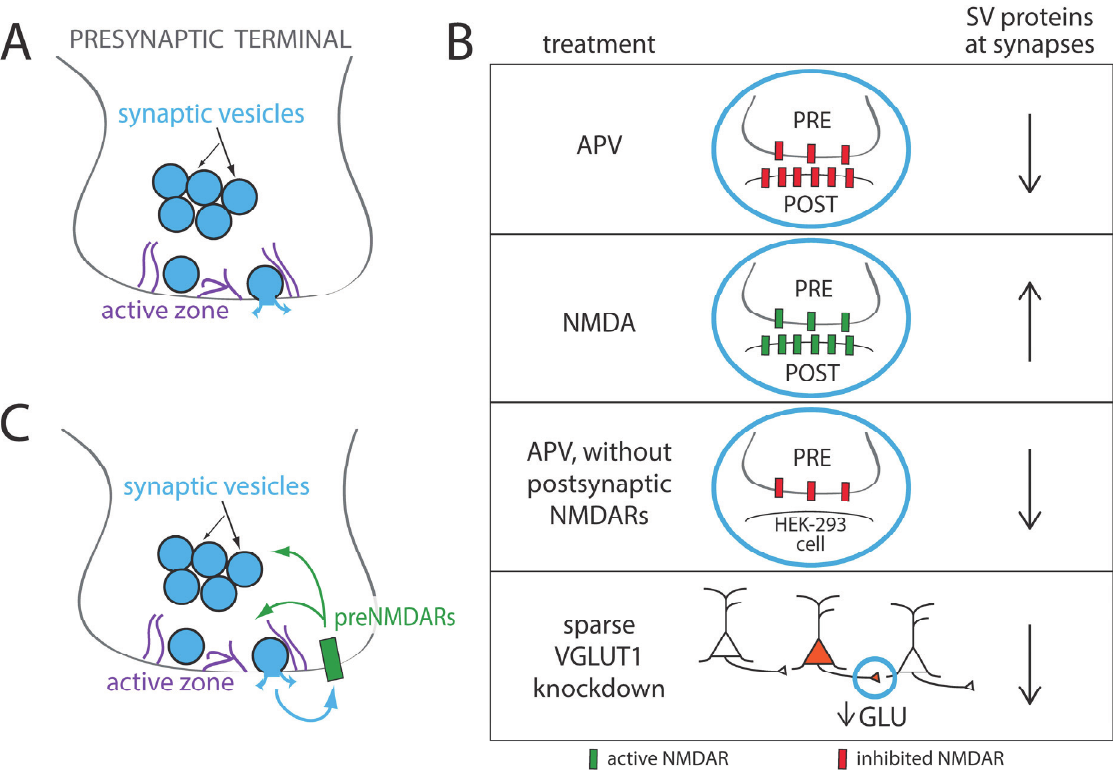
Figure 1. ( A ) Presynaptic terminals (or boutons) are specialized structures that form within axons at sites of synaptic contact with postsynaptic partners. Presynaptic terminals contain clusters of small synaptic vesicles that are loaded with small molecule neurotransmitters, such as glutamate and GABA. When an action potential invades the presynaptic terminal, synaptic vesicles fuse with a region of the plasma membrane known as the active zone, and a neurotransmitter is released into the synaptic cleft where it can bind to its receptors. Synaptic transmission occurs upon binding of receptors within the postsynaptic membrane; however, presynaptic neurotransmitter receptors also exist. The probability that a vesicle fuses in response to an action potential is known as the probability of release, and the postsynaptic response induced by fusion of a single vesicle is referred to as a miniature excitatory postsynaptic current, or mEPSC; ( B ) Presynaptic development is regulated by NMDA receptor activation, even when presynaptic terminals are formed with postsynaptic partners that lack NMDA receptors. Treatment of cortical neurons with APV, an NMDA receptor antagonist, reduced accumulation of synaptic vesicle and active zone proteins at developing synapses, while treatment with the NMDA receptor agonist NMDA did the opposite [14]. When cortical neurons formed presynaptic terminals with non-neuronal HEK-293 cells that express neuroligin but not NMDARs, treatment with APV reduced synaptic vesicle protein content at these terminals. When VGLUT1 was knocked down in individual cortical neurons in culture to reduce synaptic glutamate release, presynaptic terminals formed by those neurons had reduced synaptic vesicle protein content. This indicates that presynaptic development is regulated by glutamate release in a cell-autonomous manner [15]; ( C ) Based on these observations, we hypothesize that presynaptic NMDA receptors may facilitate presynaptic